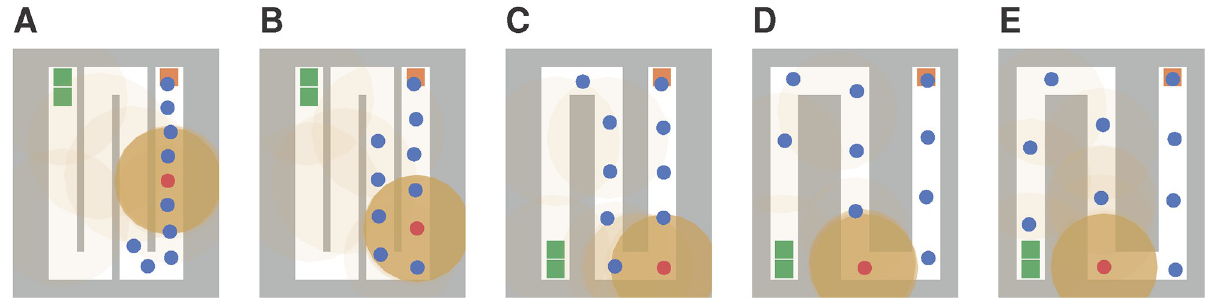
Fig 10. Queue scenarios with varying distances between virtual persons at t = 100 s. The scenarios A–E exhibit different distancing behaviours. This is achieved by increasing the potential parameter p and the centre-to-centre distance between the corridors d m; C: p = 1.5, d c = 1.5 m; D: p = 2.0, d c = 2.0 m; E: p = 2.5, d c = 2.0 m.